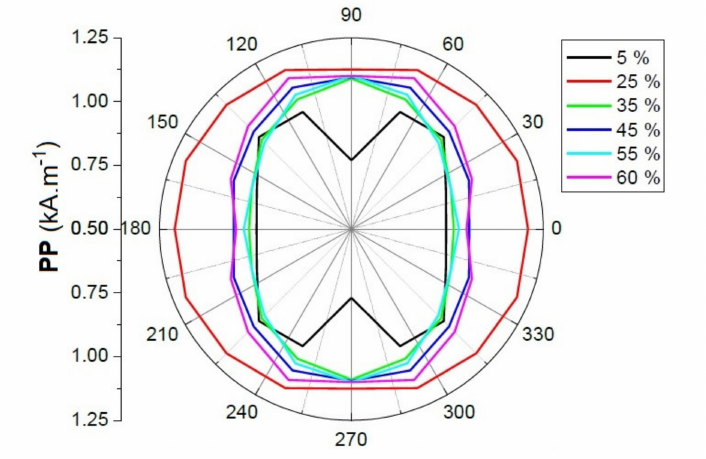
Figure 12. Angular dependence of peak position (PP) for different ε